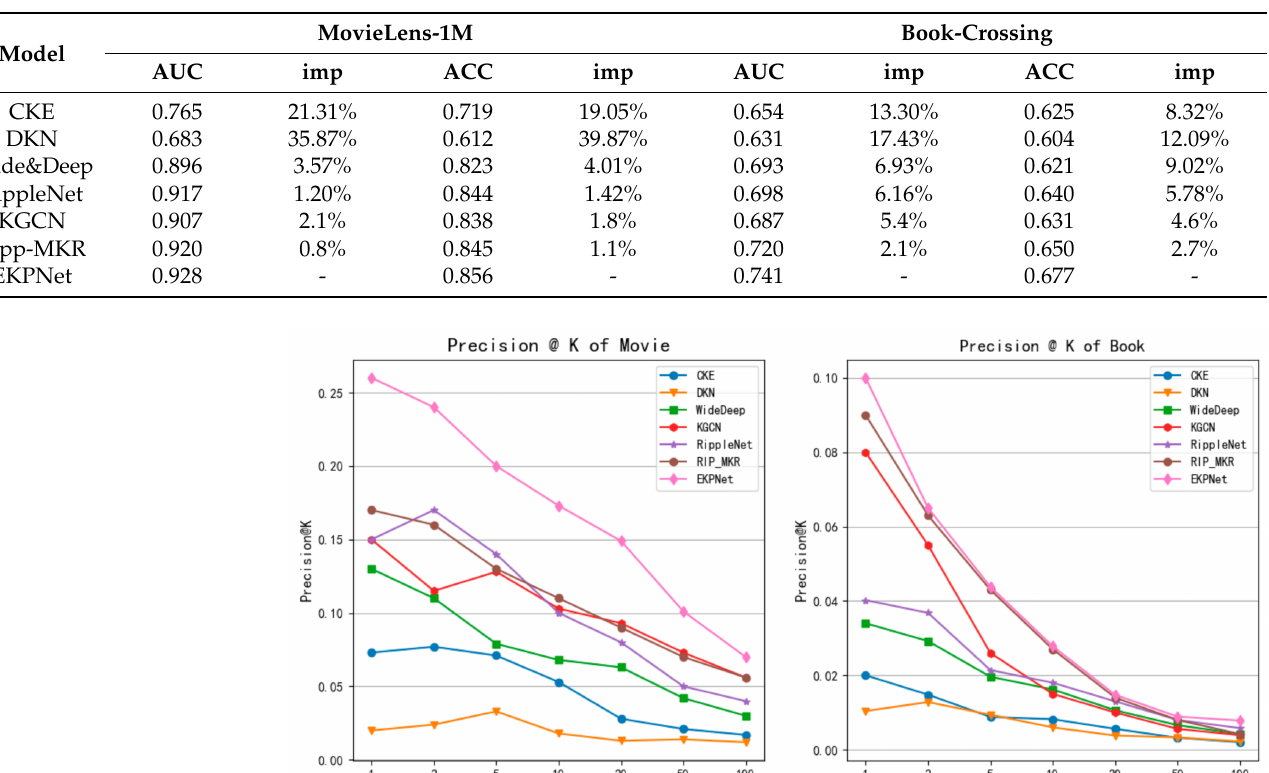
Table 3. The performance of different baselines in the two datasets in the CRT prediction task.